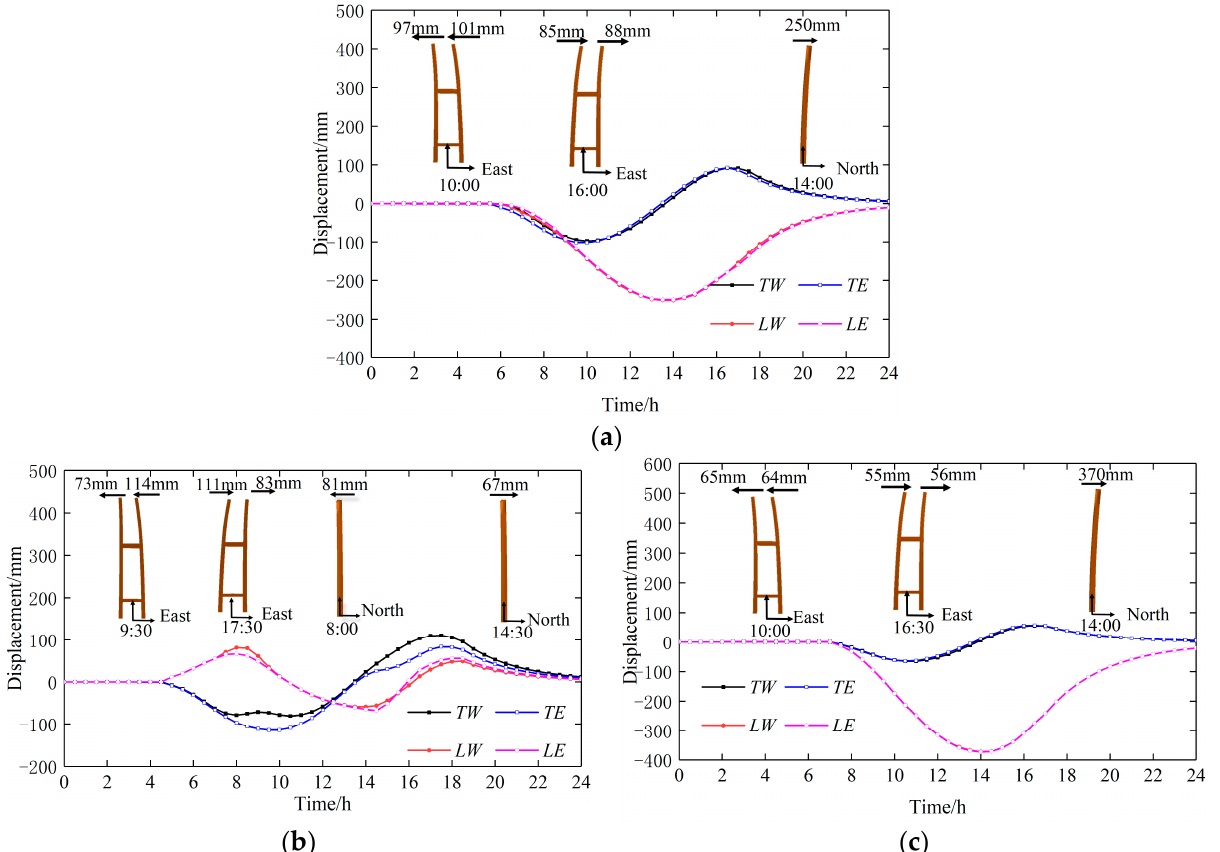
Figure 19. Displacement of pylon: ( a ) Spring (Autumn) displacement. ( b ) Summer displacement. ( c ) Winter